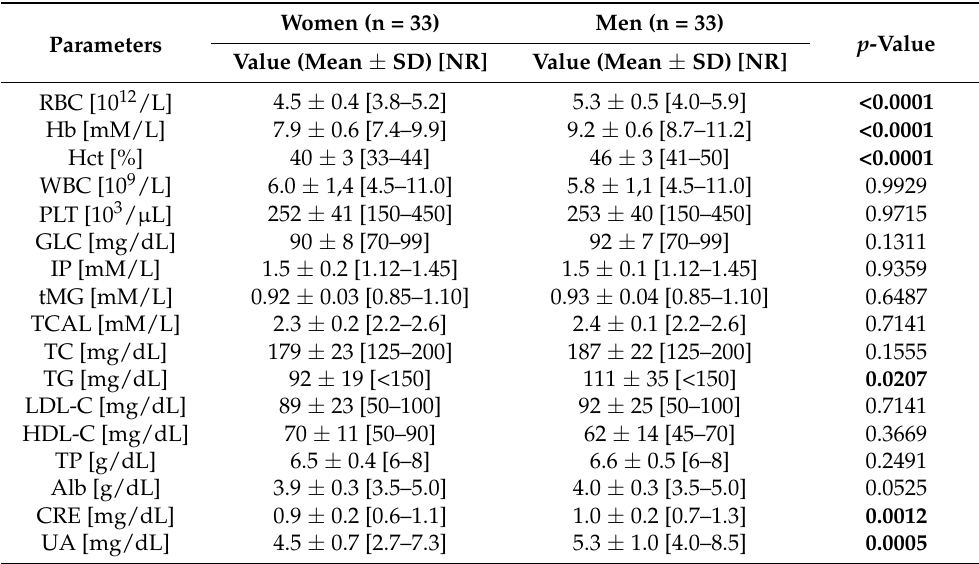
Table 1. Mean concentration of blood parameters obtained among volunteers divided by gender, p < 0.05. Parameters